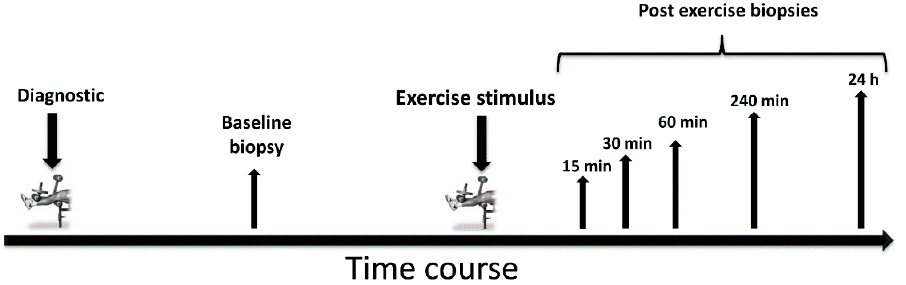
Figure 6. Baseline strength diagnostics and skeletal muscle biopsies were collected 7–10 days prior to the exercise intervention. After application of the main resistance exercise session, several skeletal muscle biopsies were collected from the exercised leg within 24 h.